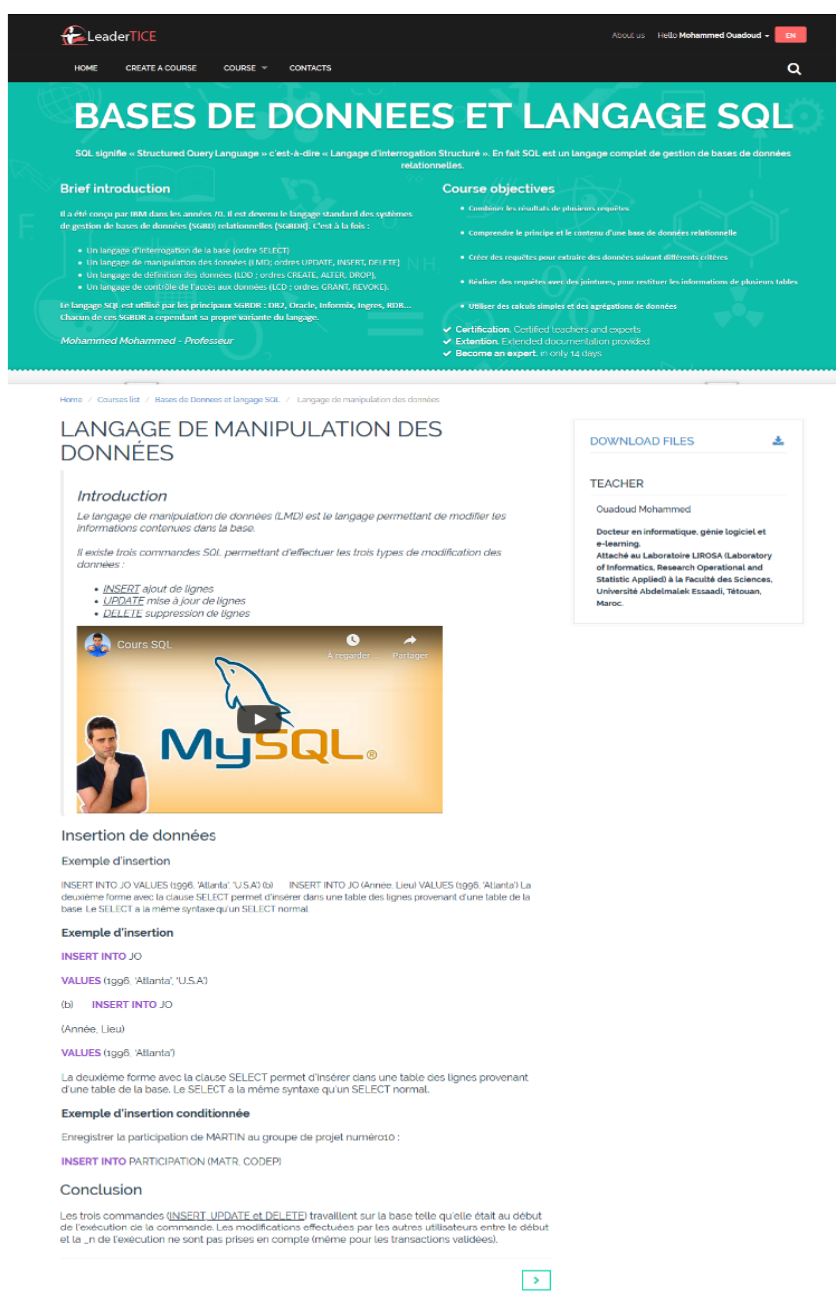
Fig. 11. Details of a course developed via Symfony